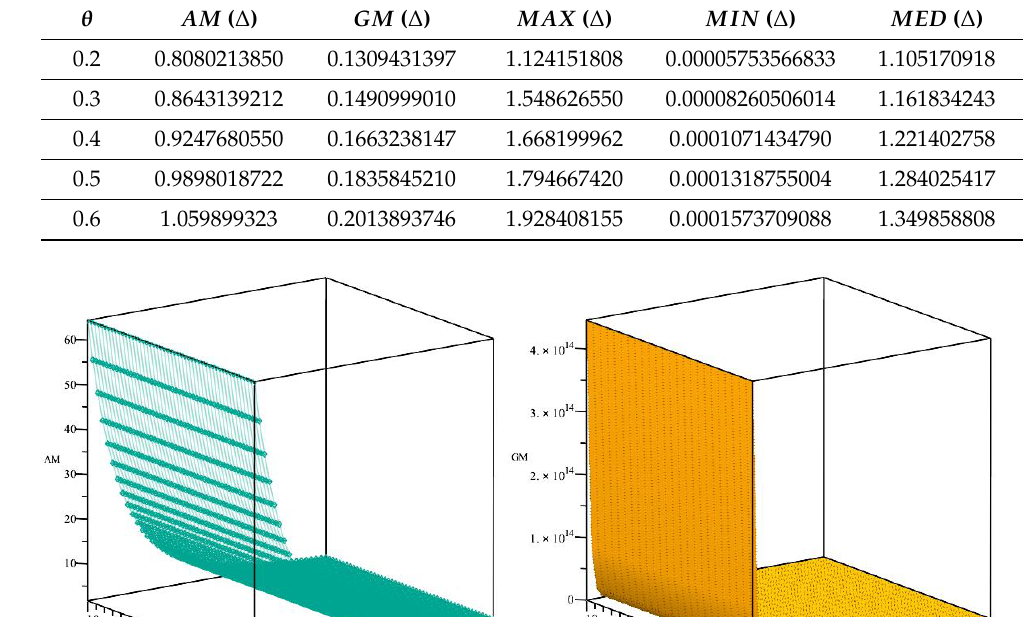
Figure 1. Graph of aggregate functions AM and GM for , τ = 2 and different values θ From the calculations, we consider the minimum function as the control function and define it as follows ϕ τ ( θ ) = ^ (cid:26) Exp ( −k θ k τ